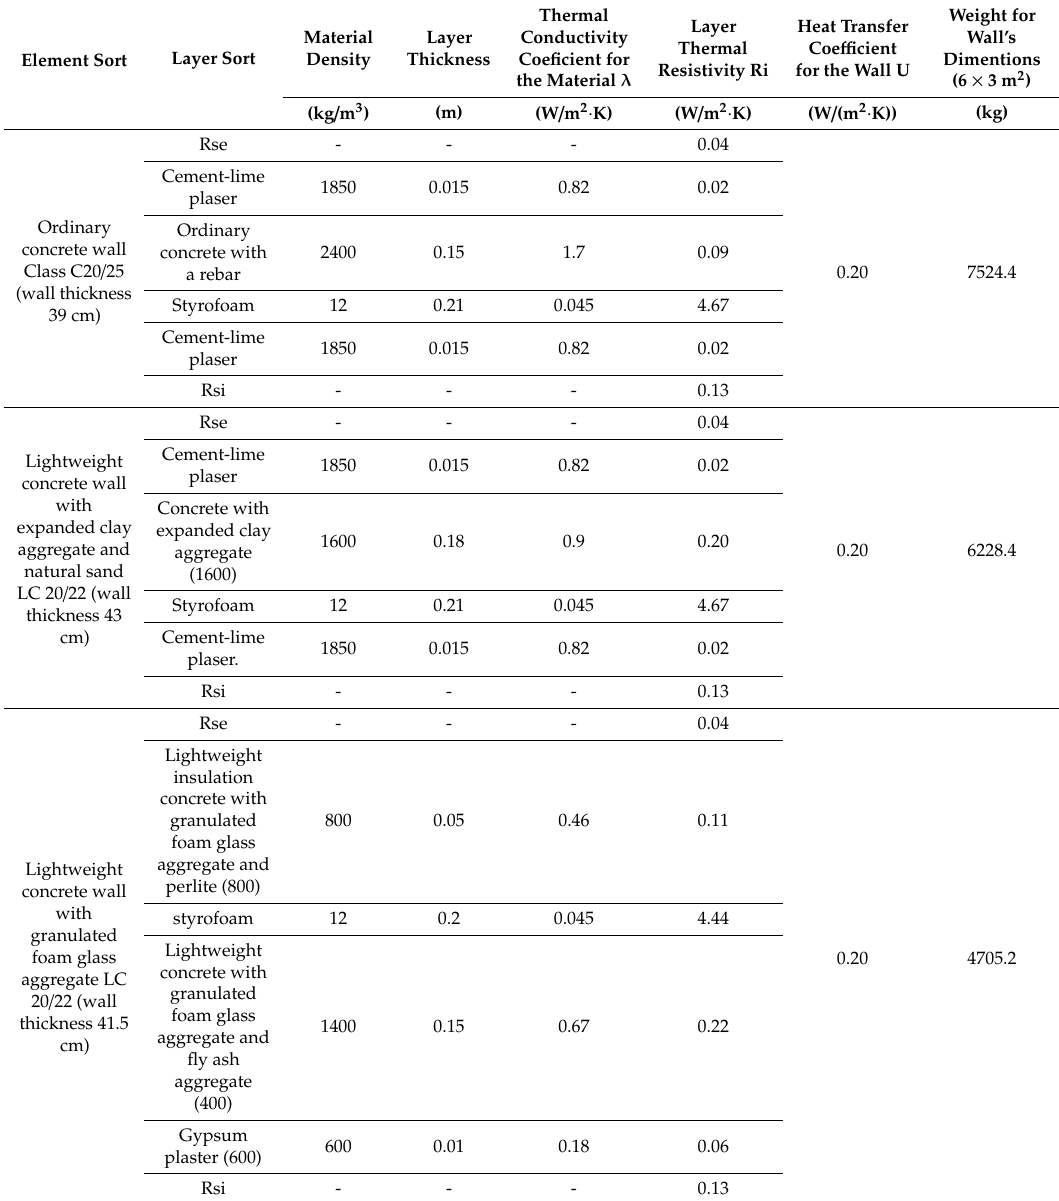
Table 5. Heat transfer coe ffi cients for an outer multilayer